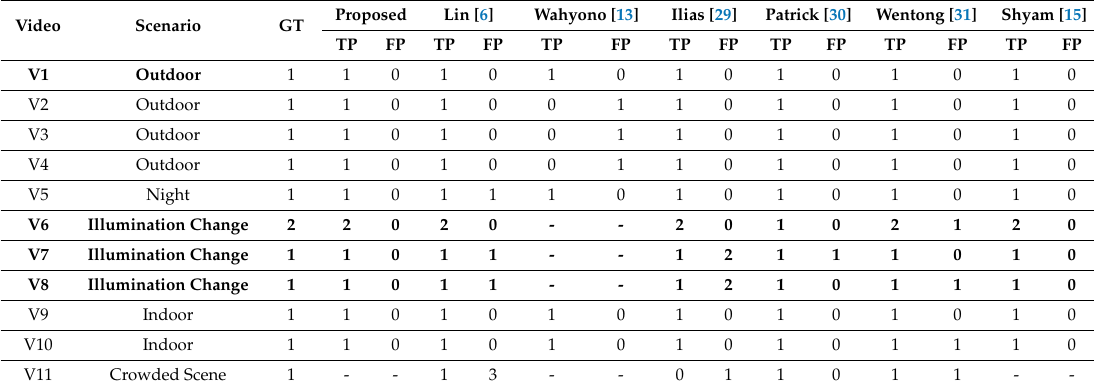
Table 2. Comparison of test results for ABODA (abandoned object